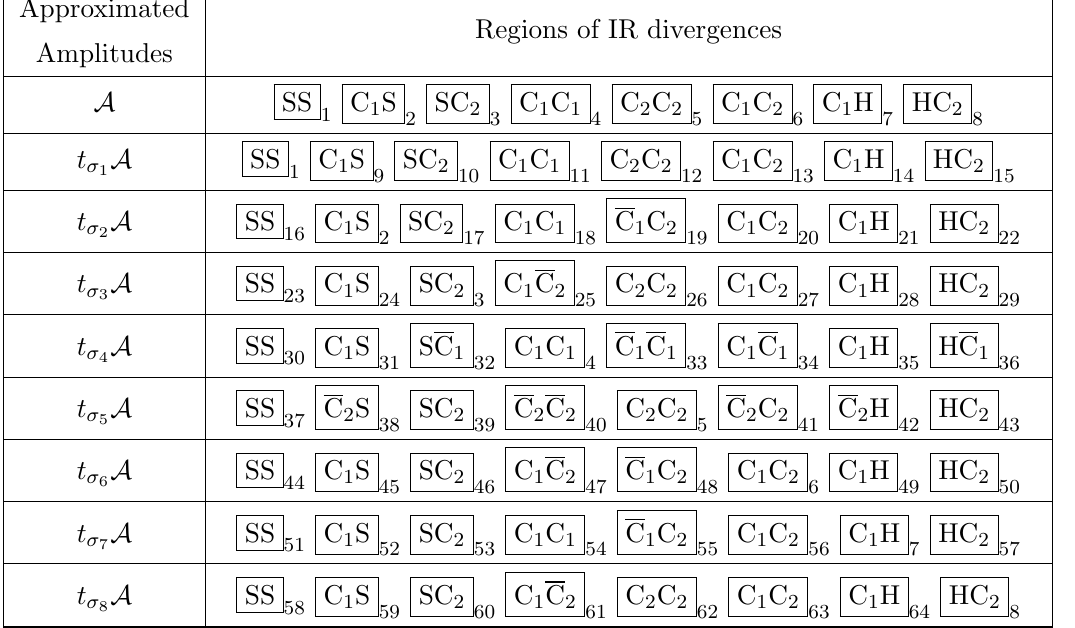
Table 6. Approximated amplitudes and their associated IR regions. Pairs of terms that cancel are indicated by matching